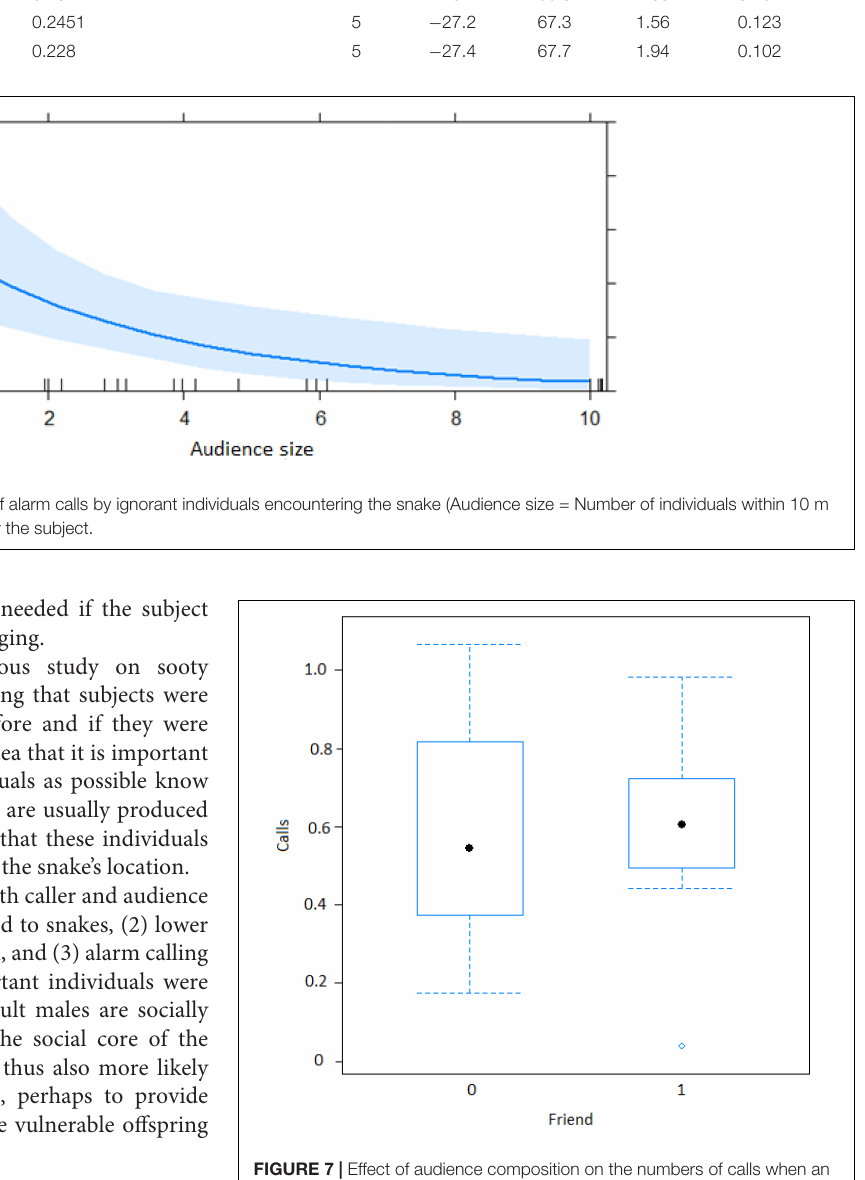
FIGURE 7 | Effect of audience composition on the numbers of calls when an ignorant individual finds the snake (Friend = Socially important individual present around 10 m of the subject). Calls: Proportion of alarm calls given by the subject. (Seyfarth and Cheney, 2010). The fact that the presence of “friends” was also associated with higher alarm calling rates ( Table 3 and Figure 7 ), suggests that grooming could be traded with warning for Gaboon or Rhinoceros